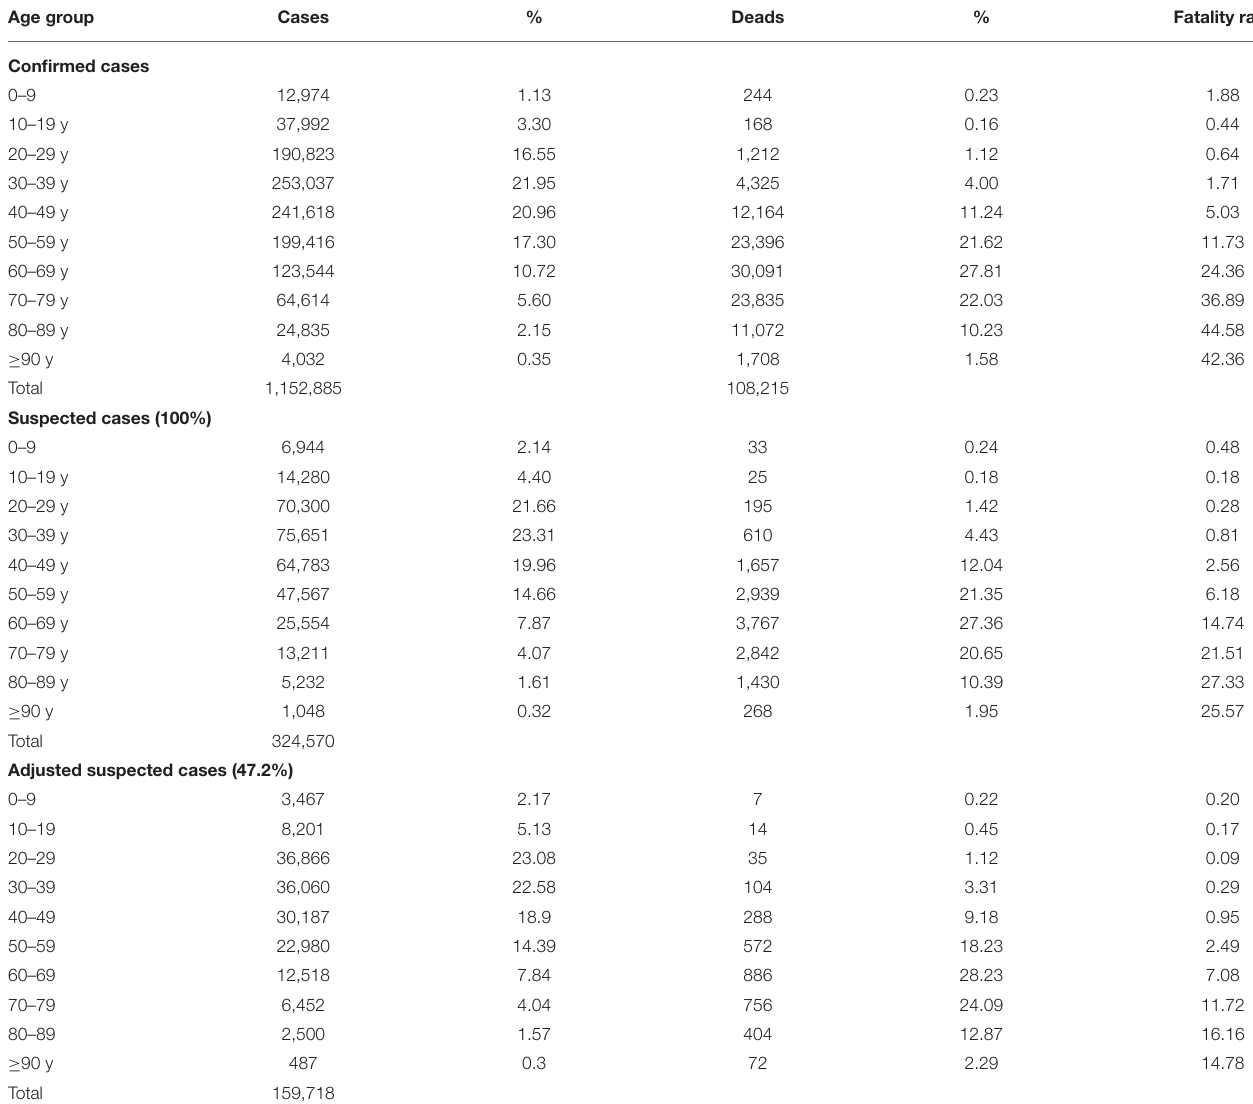
TABLE 2 | Fatality rate for COVID-19 by age